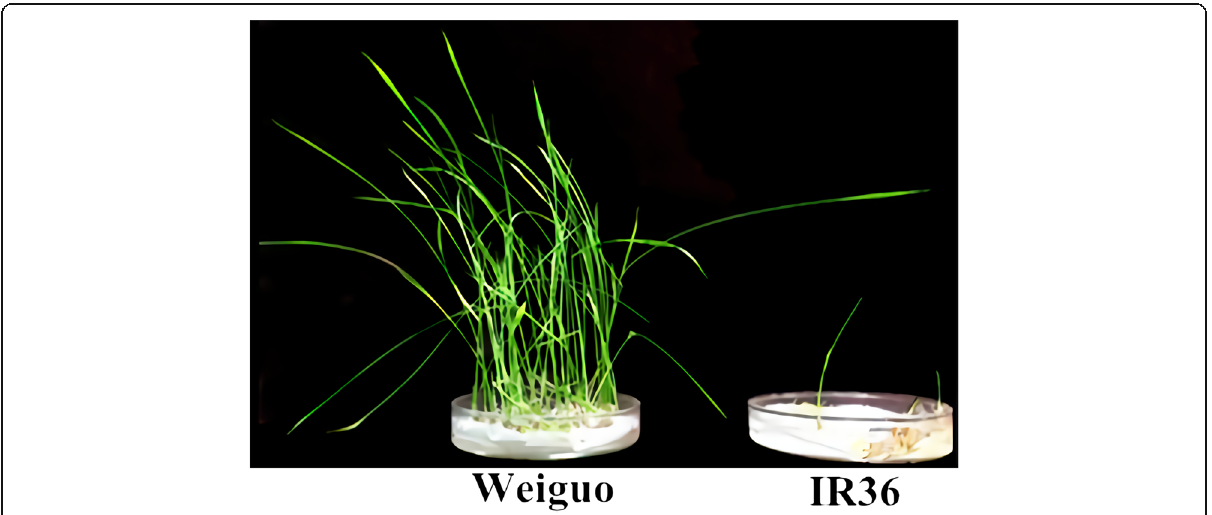
Fig. 2 The phenotype of Weiguo and IR36 after 10 days of 0.5% NaCl treatment